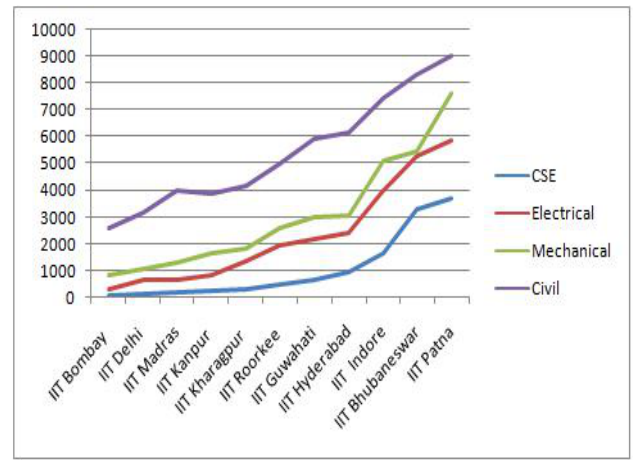
Table 4. Input Data Set for CSE branch of IIT Bombay